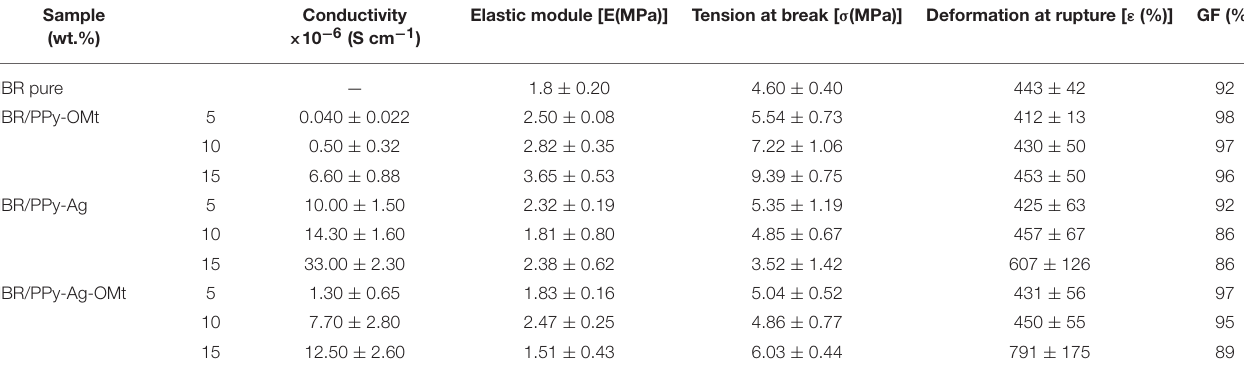
TABLE 1 | Electrical conductivity, elastic modulus, maximum stress, maximum strain, and gel fraction of NBR/PPy-OMt, NBR/PPy-Ag, and NBR/PPy-Ag-OMt conductive rubbers. Sample (wt.%)